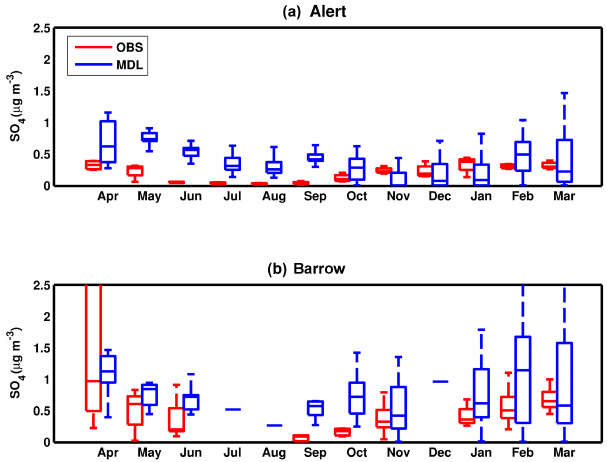
Figure 6. Comparison of simulated sulfate (SO 4 ), with observa- tions shown as box-and-whisker plots over 1 year (April 2008– March 2009) at the Alert (a) and Barrow (b) sites. In the box-and- whisker plots, the middle line denotes the median value, while the edges of the box represent 25th and 75th percentile values, respec- tively. The whiskers denote the maximum and minimum